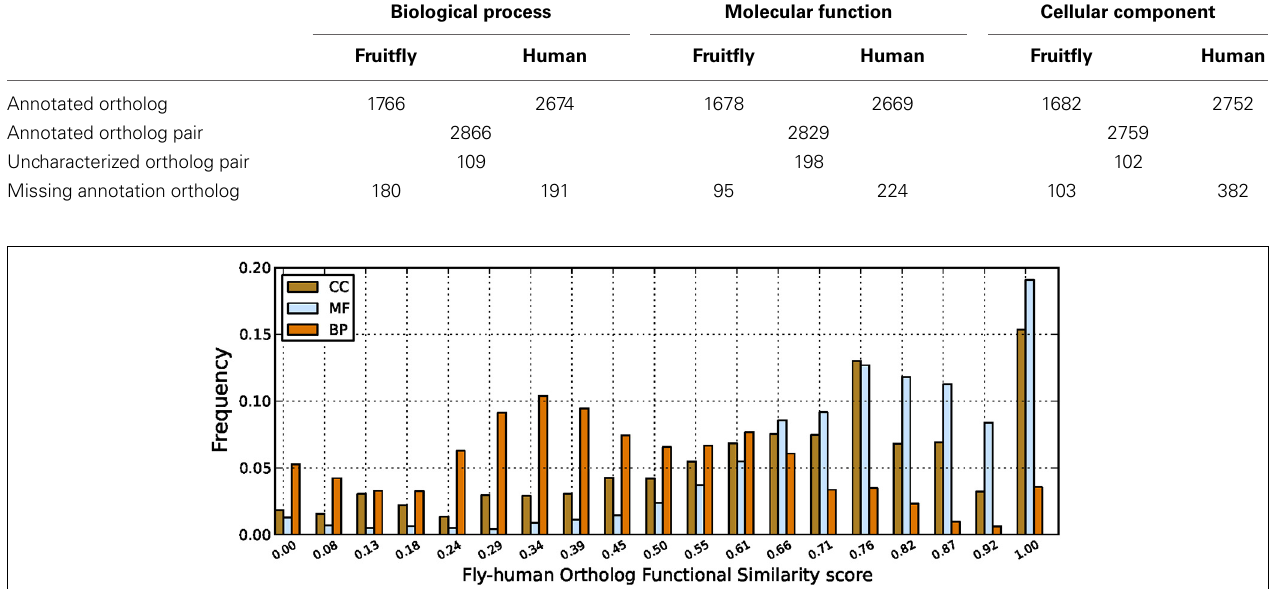
FIGURE 4 | Fruitfly-human ortholog functional similarity scores. Comparing GO annotations for ortholog protein pairs between human and fruitfly genomes with scores computed using the GO-universal metric.